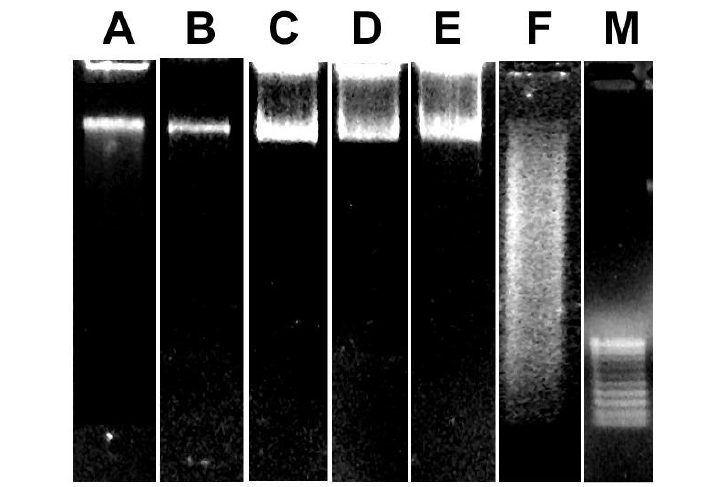
FIGURE 1. Representative VGGE of the DNA isolated from MDA- MB231 cells, cultured in control conditions (A,C,E) and in the presence of 1-nM PTHrP (38-94)-amide (B,D,F) for 6 (A,B), 24 (C,D), and 48 h (E,F). M = size marker (100-bp ladder).